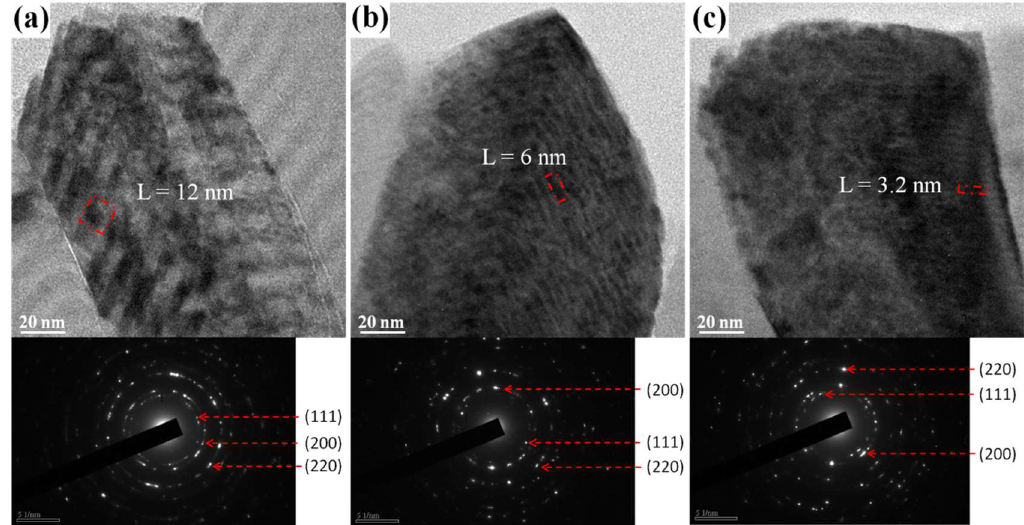
Figure 2. TEM micrographs and corresponding diffraction patterns of CrN/CrAlSiN multilayer films fabricated using various rotation speeds: ( a ) 1.5; ( b ) 3; and ( c ) 5 rpm.